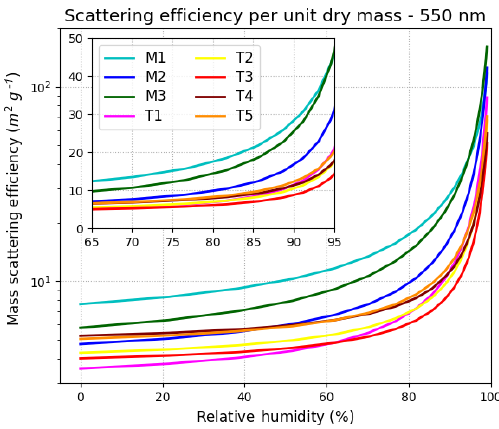
Figure 8. Reconstructed mass scattering efficiencies (per unit dry aerosol mass) for each of the cluster population types across a range of environmental relative humidity values. An assumed dry index of refraction of 1 . 5 + 0 . 0 i was used for all population types to highlight the differences in aerosol optical properties expected due to differ- ences in population average size distribution, hygroscopicity, and relative